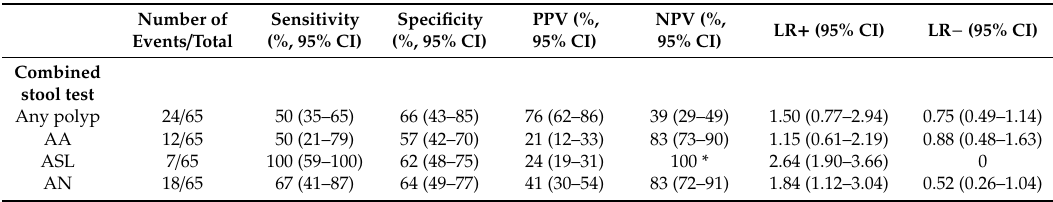
Table 4. Performance of fecal immunochemical test at cut-o ff of ≥ 10 µ g Hb / g feces (FIT10) and multi-target stool DNA test (mt-sDNA)